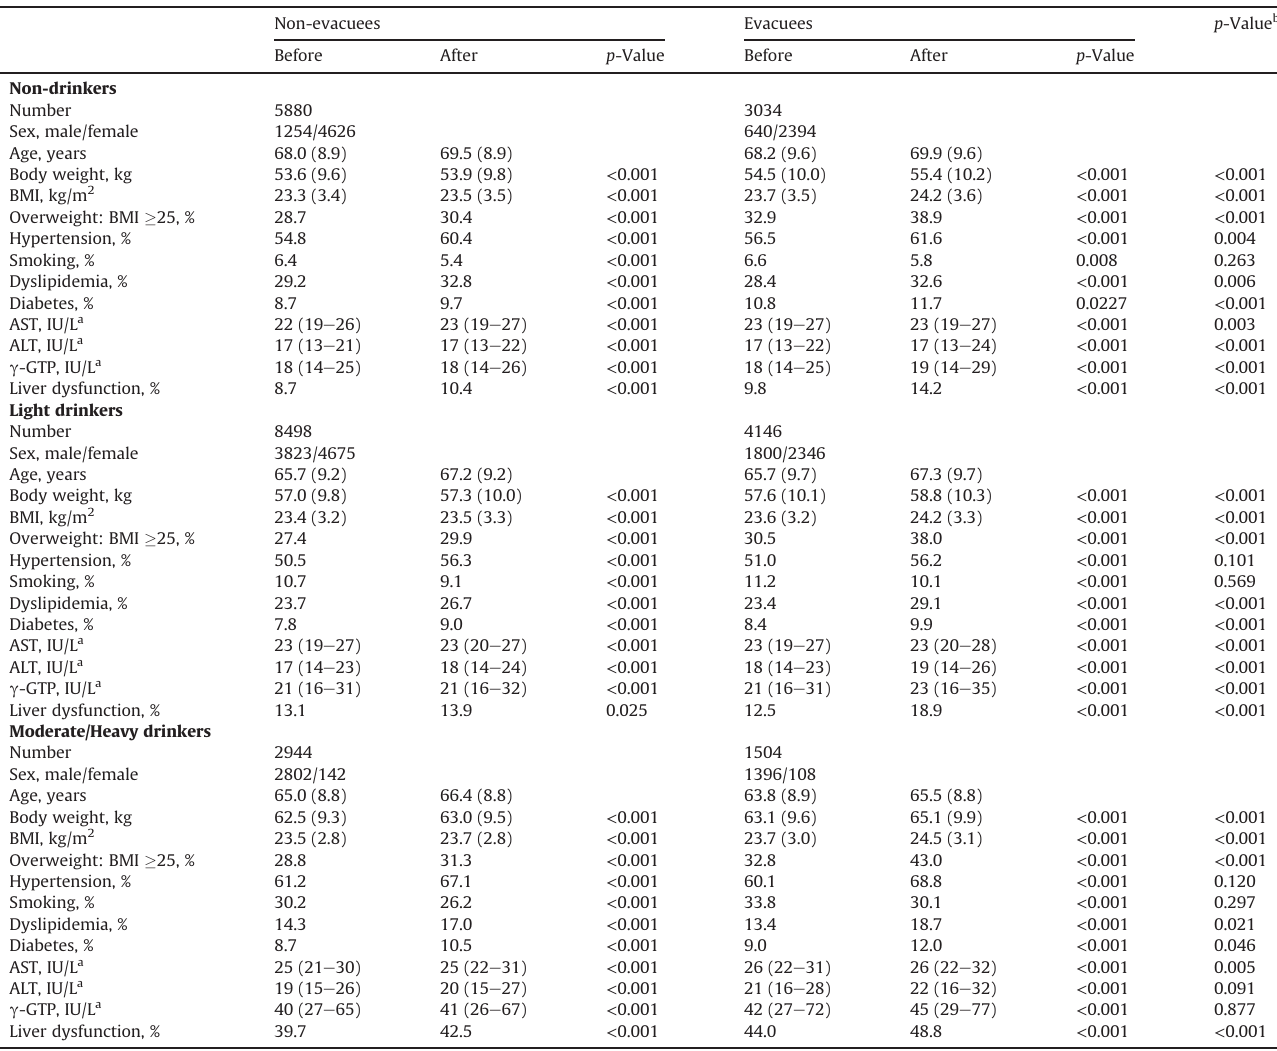
AST, aspartate aminotransferase; ALT, alanine aminotransferase; BMI, body mass index; g -GTP, gamma-glutamyl transpeptidase. Data are mean values (standard deviation) for continuous variables and percentage values for categorical variables, unless otherwise noted. a Reported as median (interquartile range). Table 2 Changes in clinical and biochemical characteristics between non-evacuees (n ¼ 17,322) and evacuees (n ¼ 8684) after the Great East Japan Earthquake. Non-evacuees Evacuees p -Value b Before After p -Value Before After p -Value Non-drinkers